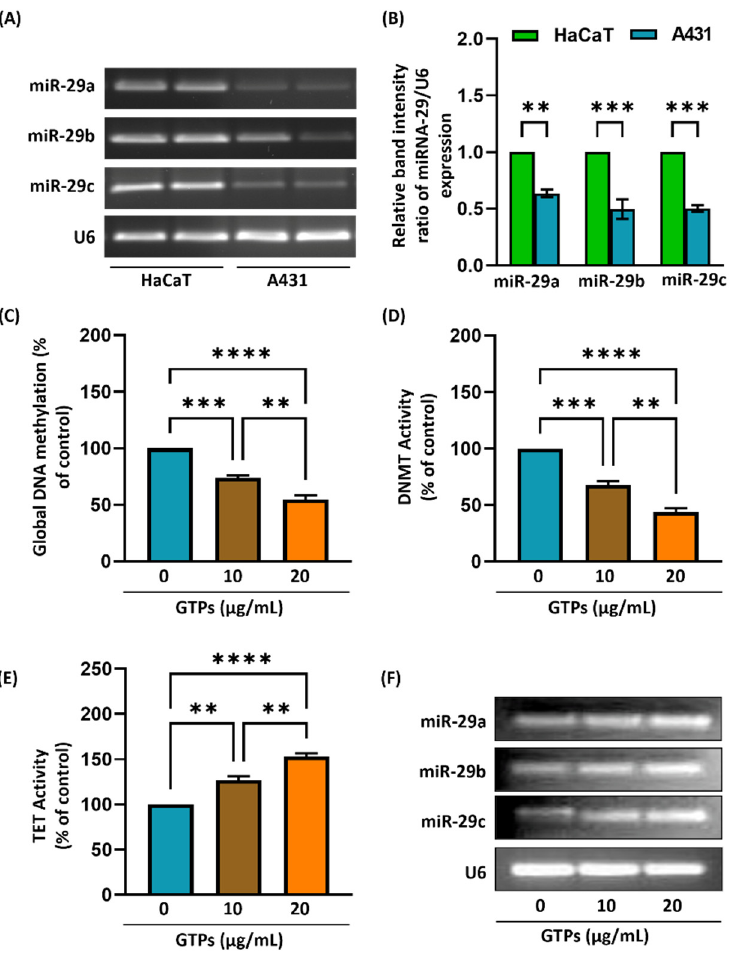
Figure 5. Expression of miR-29 in A431 and the effect of GTPs on epigenetic modulators and miR-29 family members in skin cancer cells. MiR-29 expression in A431 and HaCaT cells ( A , B ). Skin cancer cells (A431) were treated with GTPs in dose-dependent manner (0, 10, 20 µg/mL) for 5 days. After 5 days of GTPs treatment, the levels of global DNA methylation ( C ), DNMT activity ( D ), and TET activity ( E ) were measured in all groups. Effect of GTPs on miR-29a, 29b, and 29c ( F ). U6 was used as a loading control. Data are presented as a percentage of the control (non-GTPs-treated) group, which was assigned a value of 100%, and as means ± S.E.M, n = 3. ** p < 0.002, *** p < 0.0009, **** p < 0.0001.